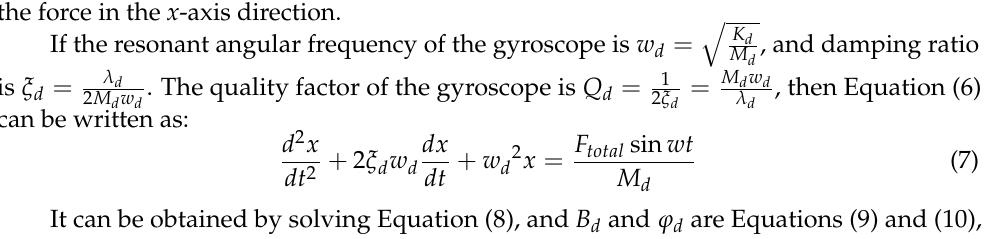
where the equivalent mass in the x -axis direction is M d , the damping force coefficient and the elastic coefficient in the x -axis direction are λ d and K d , respectively, and F tot represents the force in the x -axis